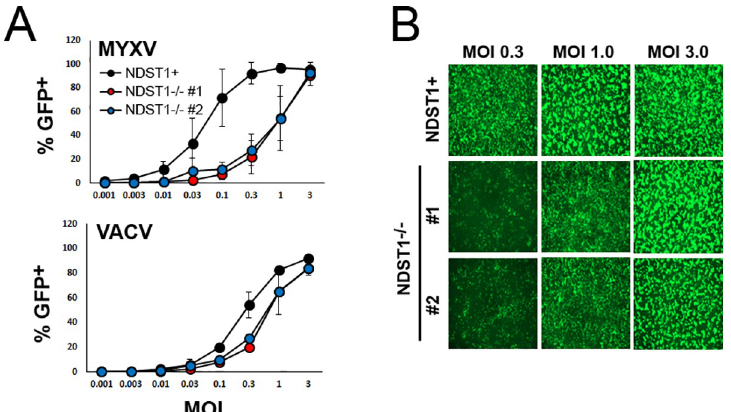
Fig 3. Loss of sulfation reduces initial infection of both MYXV and VACV. (A) Number of GFP + cells found 24 hours after infection with either MYXV or VACV at multiple MOI’s. Data shown is the summation of two independent experiments each conducted in triplicate. (B) Fluorescent images of cells infected for 24 hours with MYXV at an MOI of 1, 3, and 9 shown as an example.